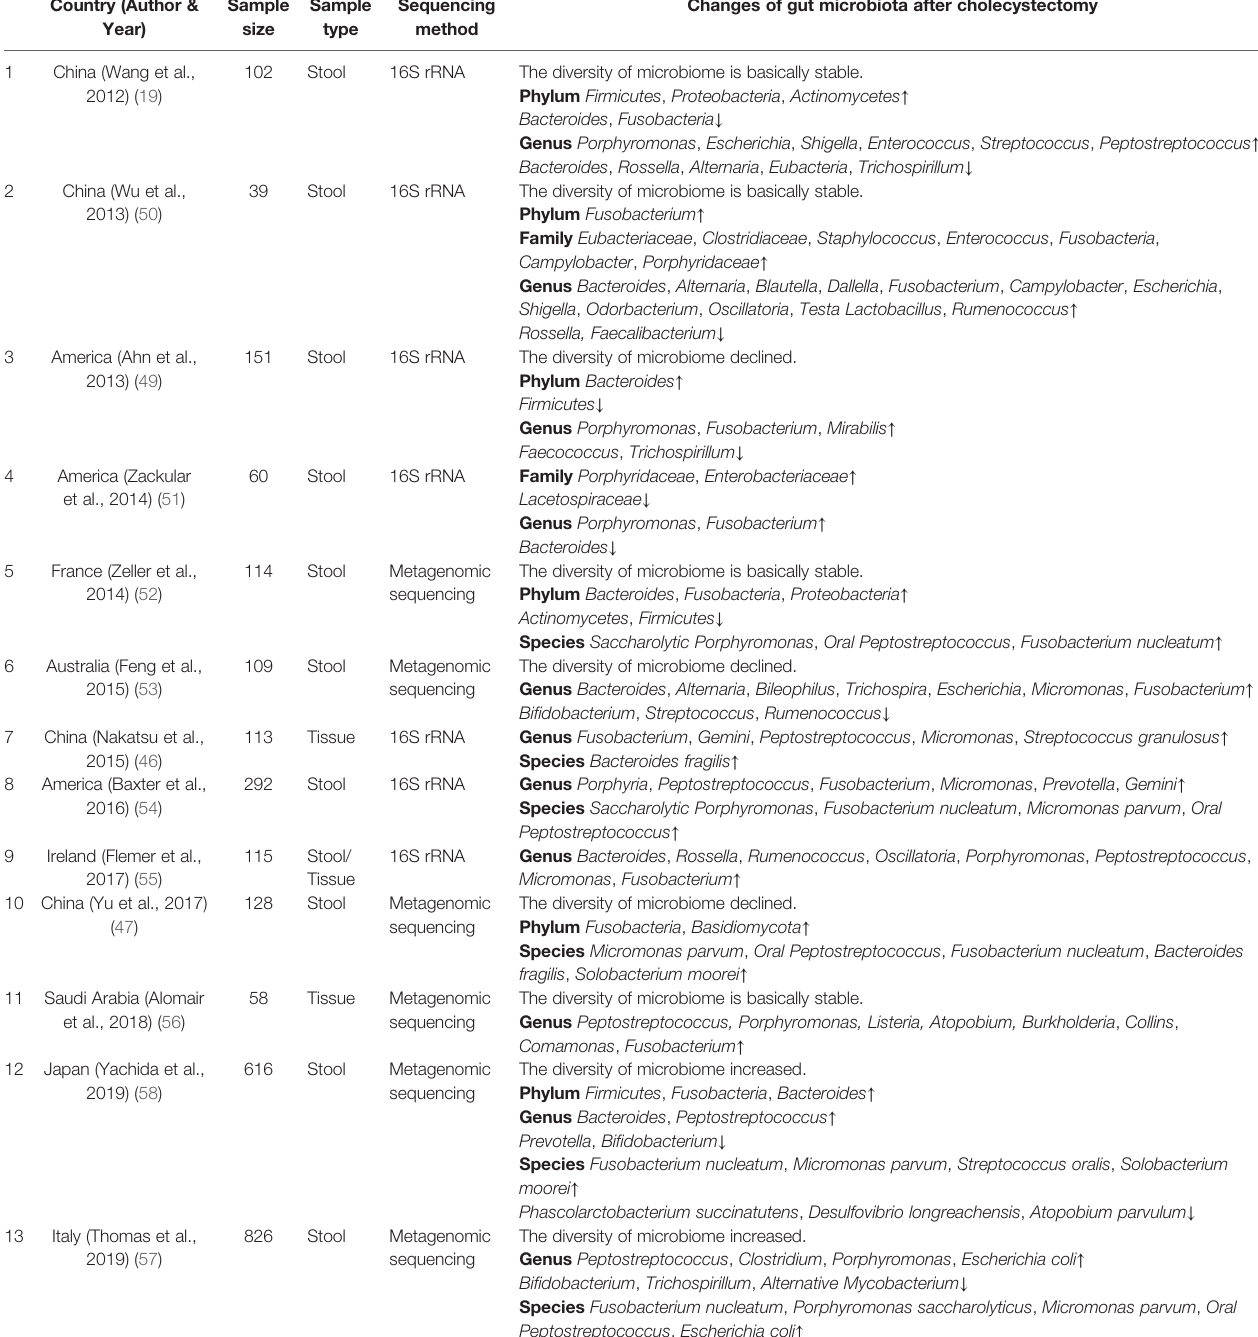
TABLE 2 | Comparison of gut microbiota between patients with colorectal cancer and healthy individuals. Country (Author &